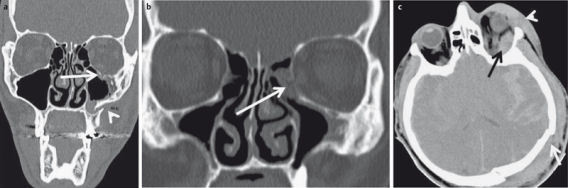
CT of the midface for detection of orbital fractures.a) 23-year-old football player with direct trauma to the left face and new onset of diplopia. Fracture of the floor of the orbita (arrow) with herniation of extraconal fat.b) 41-year-old patient with direct trauma to the globe. Fracture of the medial wall of the orbita and herniation of the medial rectus muscle (arrow).c) 86-year-old patient with severe head injury and rapid onset of exophthalmos. Intraorbital extraconal hematoma (black arrow) and periorbital hematoma (arrowhead). Impression fracture of the skull (white arrow).